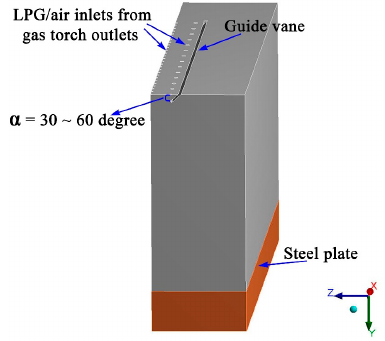
Figure 16. Guide vane angle variation from the jet flow of the gas torch.